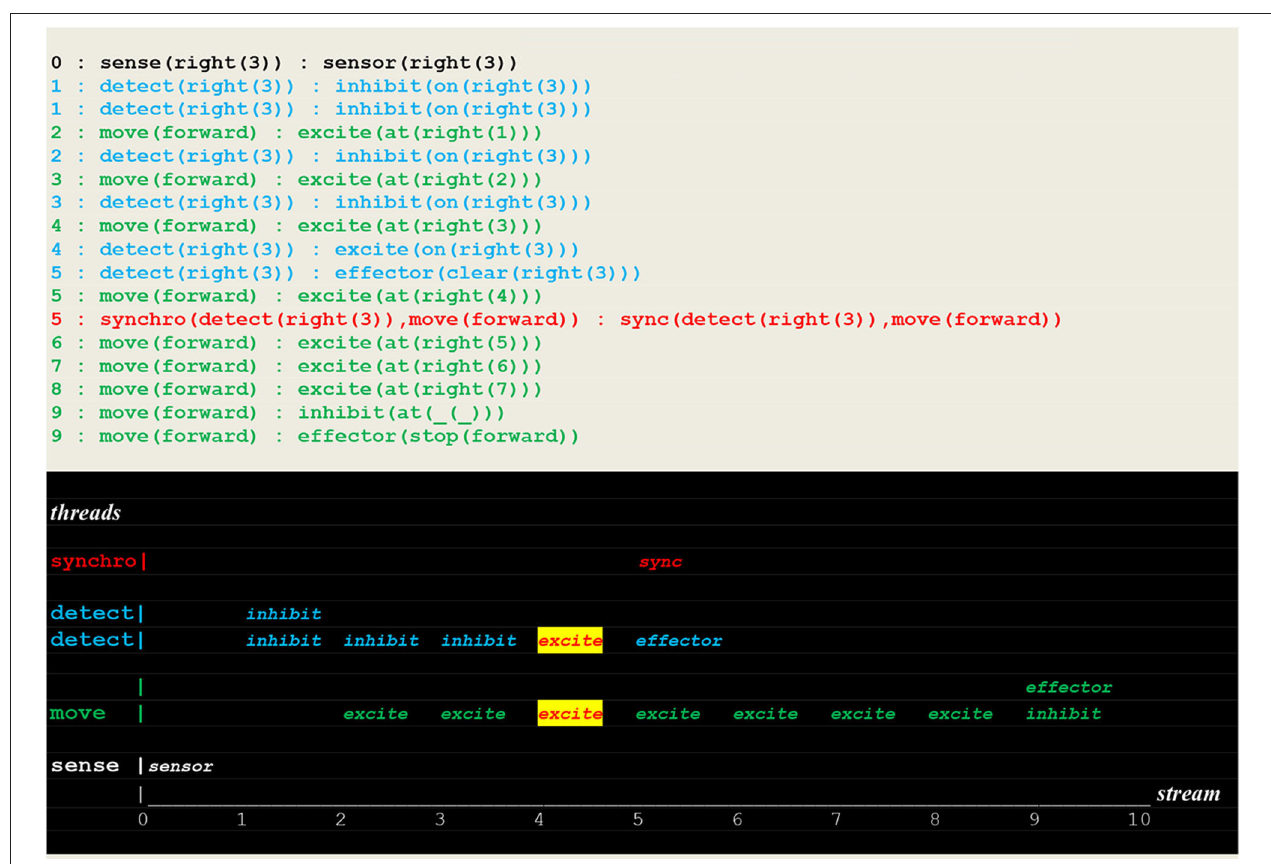
FIGURE 15 | Execution trace of a repeated move. Facing a closed path to learn , the vehicle did proceed without fetch stimulus (but with a repeated inhibit at time 1), and went through the open path of recall to detect a fire at the same position as